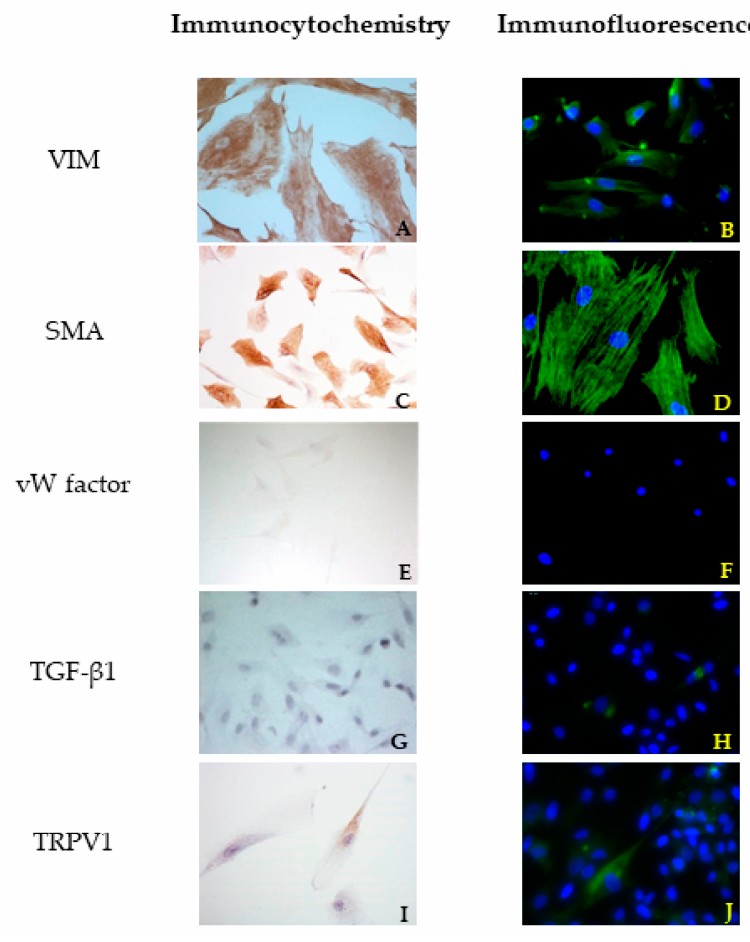
Figure 2. Results of immunocytochemistry (ICC) ( A , C , E , G , I ) and immunofluorescence ( B , D , F , H , J ) assays using vimentin (VIM), actin smooth muscle (SMA), von Willembrand (vW) factor, Trasforming growth Factor (TGF) β 1, and Transient Receptor Potential Vanilloid 1 (TRPV1) antibodies in cells derived from a healthy mitral valve.